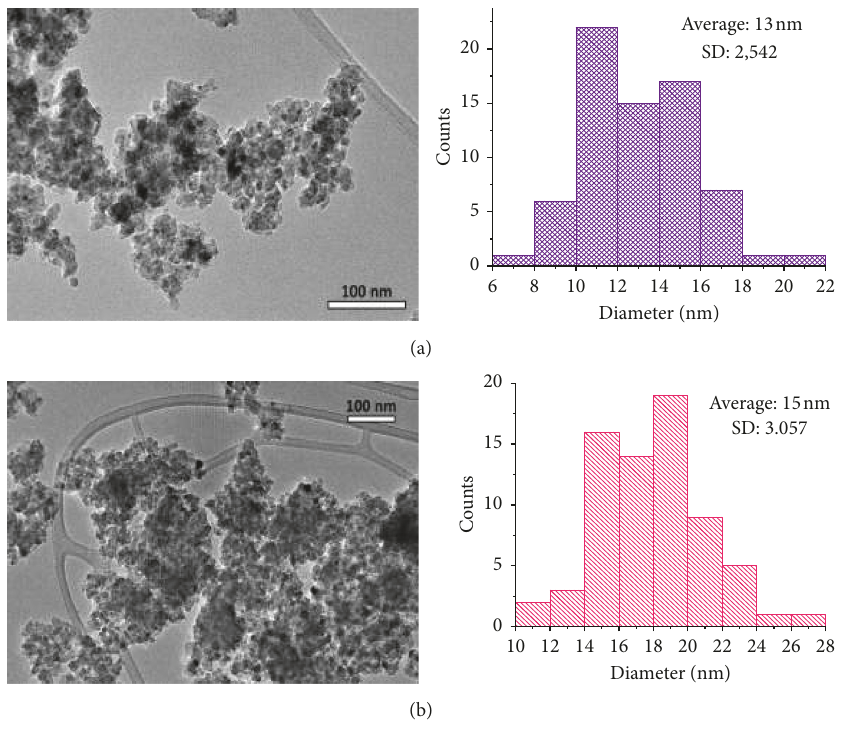
Figure 7: TEM images and particle size distribution of (a) Fe: Ti � 0 and (b) Fe:Ti � 0.